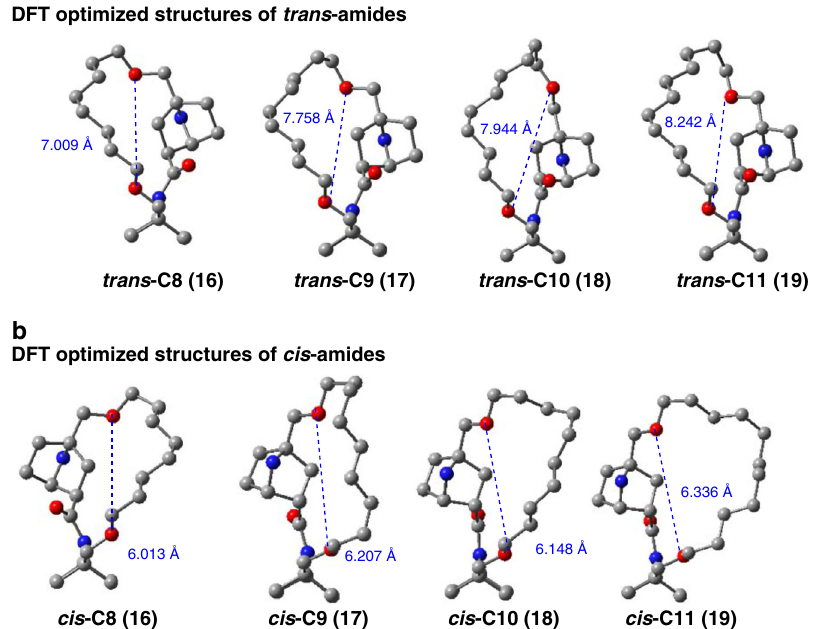
Fig. 4 DFT-optimized structures of 16(C8) - 19(C11) . a DFT-optimized trans -isomers of 16(C8) - 19(C11) . b DFT-optimized cis -isomers of 16(C8) - 19(C11) . The distance between the ether oxygen atoms in the linker is shown in blue. Brown/gray: carbon atom; blue: nitrogen atom; red: oxygen atom. All hydrogen atoms are omitted for